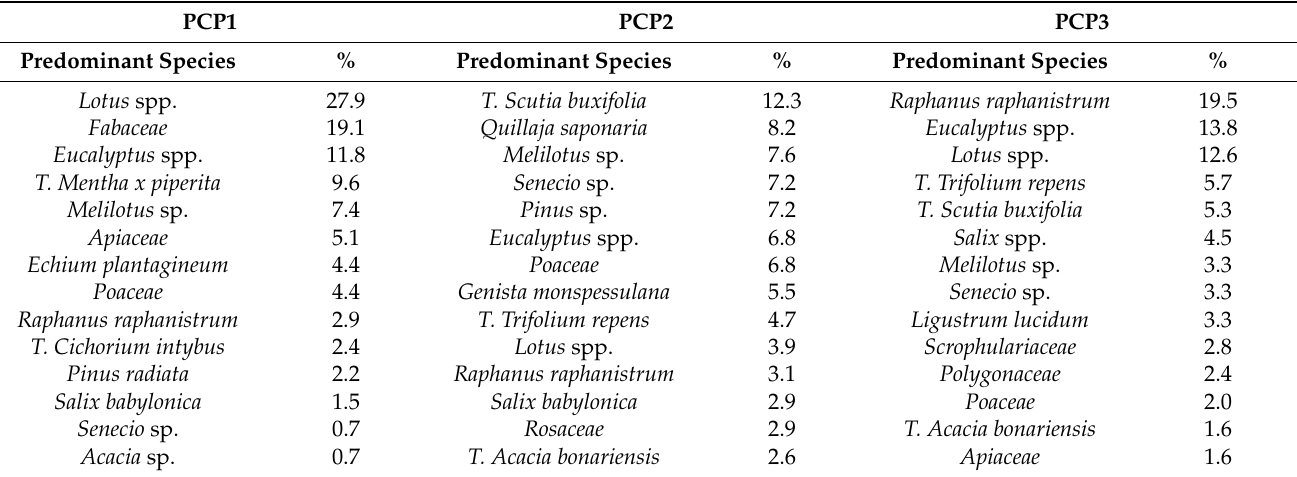
Table 1. Floral composition of chilean propolis PCP1, PCP2 and PCP3